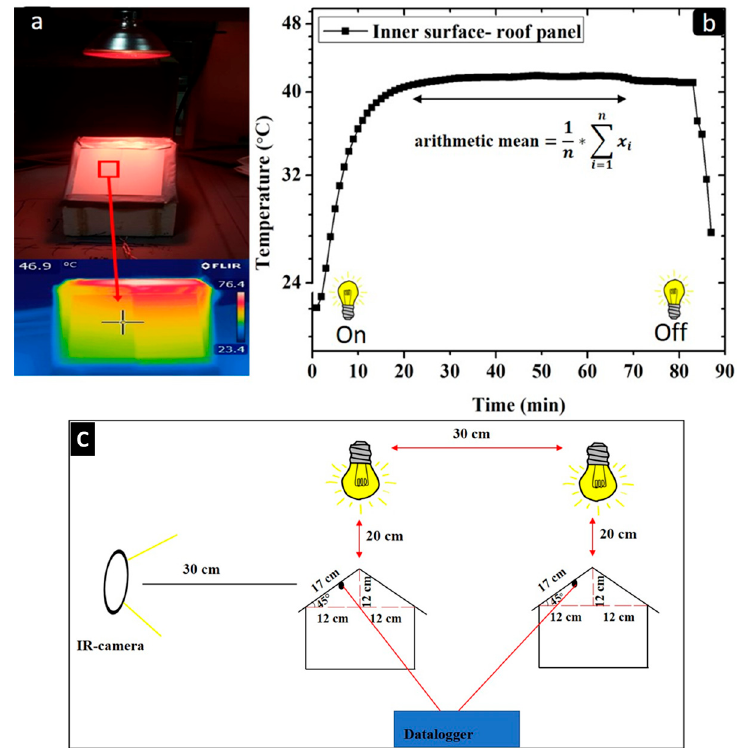
Figure 3. ( a ) IR-image obtained by an IR camera of the outer surface of the roof panel; ( b ) temperature profile of the inner surface of roof panel during measurement; ( c ) experimental setup for the thermal measurements of the coated metal substrates.